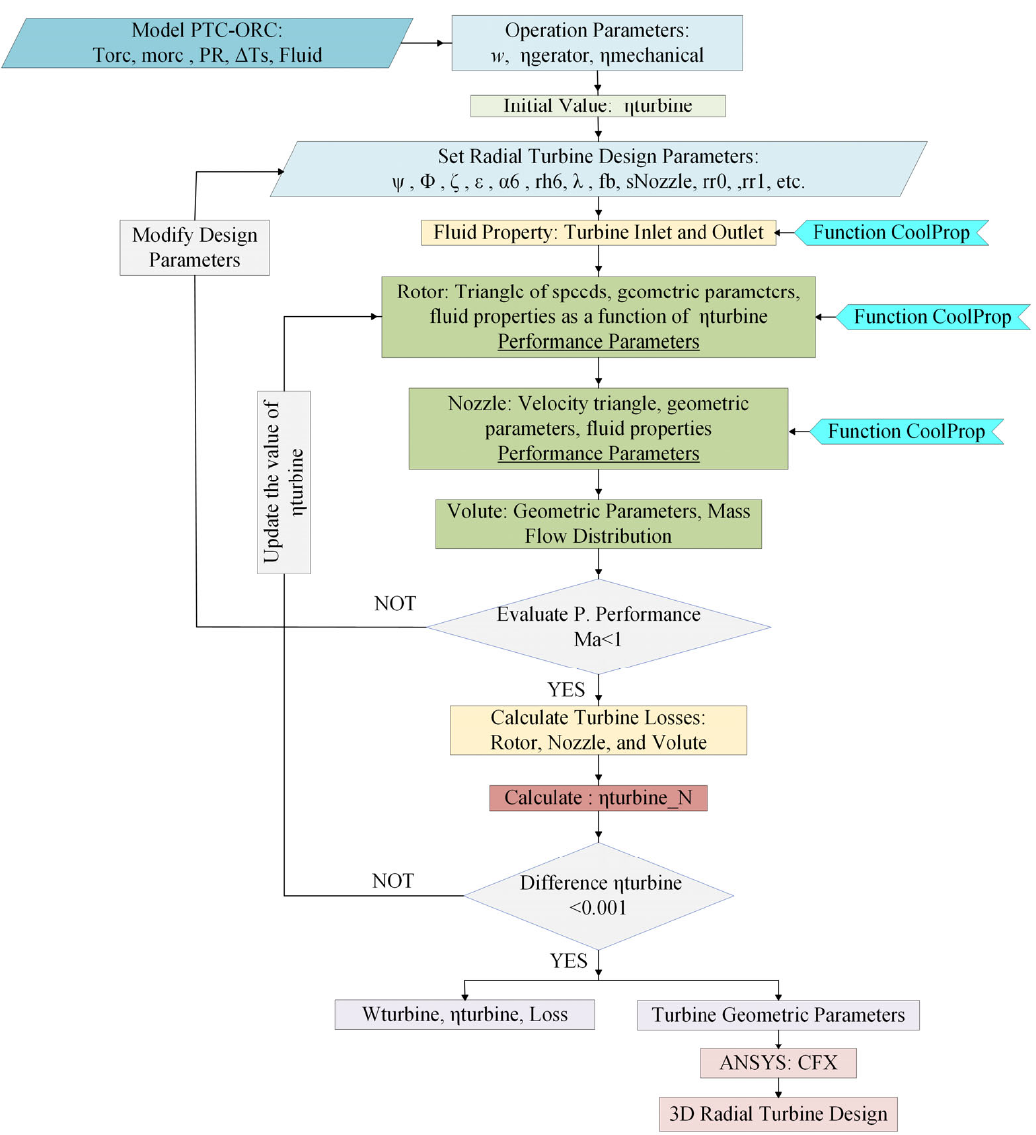
Figure 1. Calculation algorithm for a preliminary design of a radial inflow turbine. As shown in Figure 1, in the initial phase of the calculation algorithm, the necessary parameters were introduced in the power block to characterize the energy source. Subse- quently, some operating and design parameters and operating conditions were defined, including the initial value of turbine efficiency. By following the defined steps, the design parameters, necessary for characterizing the rotor, nozzle, and volute, can be calculated, as well as the properties of the working fluids in different sections. To calculate the proper- ties of the working fluids, mathematical functions were developed and implemented in MATLAB using CoolProp